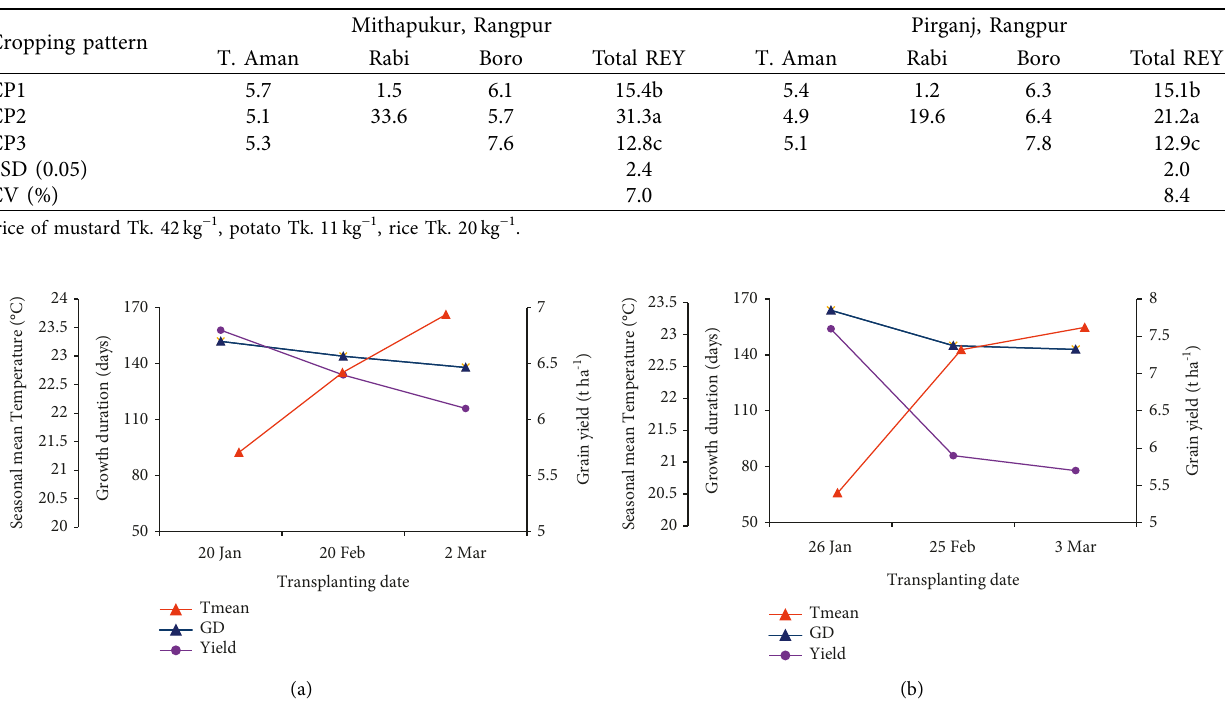
Figure 3: Effect of seasonal mean temperature on grain yield and growth duration (GD) of (a) BRRI dhan58 during Boro 2018–2019 and